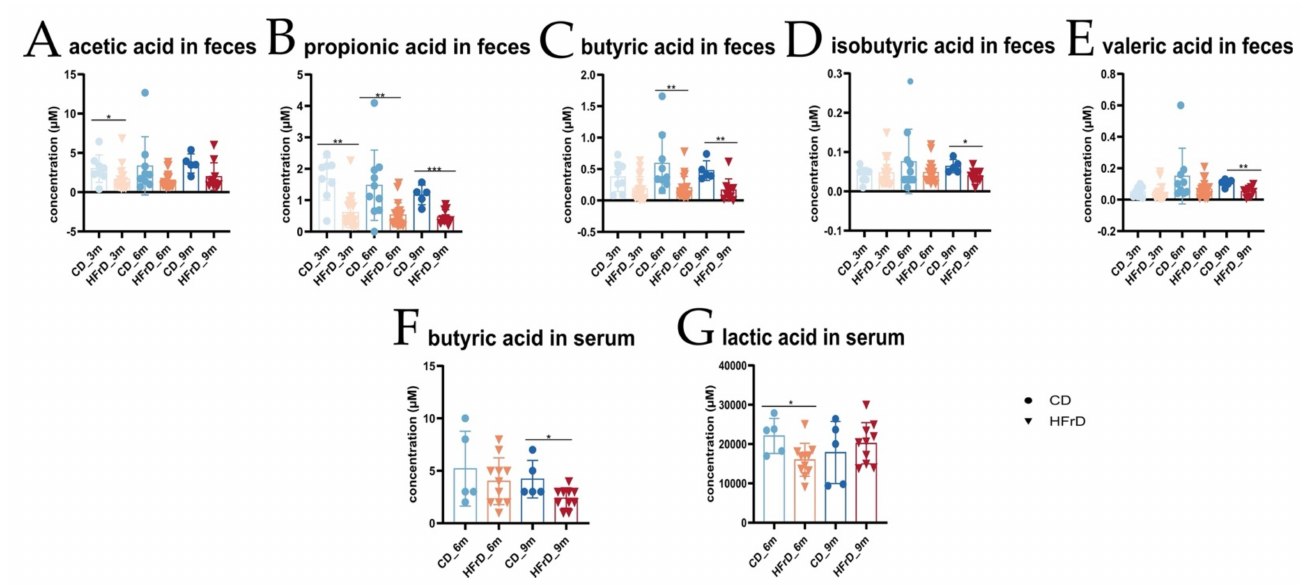
Figure 4. SCFA profiles in fecal samples taken at different timepoints and serum samples taken at dissection day. ( A ) Acetic acid in feces. Content decreased significantly in samples of 3-month-old HFrD-fed mice in comparison with CD-fed mice ( p = 0.0278); ( B ) propionic acid in feces. Compared with age-matched controls, content decreased significantly in 3-month- ( p = 0.0017), 6-month- ( p = 0.0022), and 9-month-old HFrD-fed mice ( p = 0.0003); ( C ) butyric acid in feces. Content decreased significantly in 6-month- ( p = 0.0020) and 9-month-old HFrD-fed mice ( p = 0.0080) compared with controls; ( D ) isobutyric acid in feces. Content decreased in HFrD-fed mice of all age stages in comparison with age-matched controls. However, the difference was only significant in the 9-month-old cohort ( p = 0.0195); ( E ) valeric acid in feces. In all age stages, content tended to be lower in HFrD-fed mice than in CD-fed mice. Here, the difference was also significant in only the 9-month-old cohort ( p = 0.005); ( F ) butyric acid in serum. Content was significantly lower in 9-month-old HFrD-fed mice than in 9-month-old CD-fed mice ( p = 0.0231); ( G ) lactic acid in serum. Content decreased significantly in 6-month-old HFrD-fed mice in comparison with 6-month-old CD-fed mice; statistical comparison between intervention groups and age cohorts. Data are represented as mean ± SD. Depending on the normal distribution of the data, either an unpaired t -test or a Mann–Whitney test was used for the statistical analysis. ( A – G ): circles represent samples from CD-fed mice and triangles represent samples from HFrD-fed mice. Increasing blue shades correspond to CD-fed mice (3m to 9m) and increasing red shades correspond to HFrD-fed mice (3m to 9m). Significance level: * (significant); ** (very significant); *** (extremely